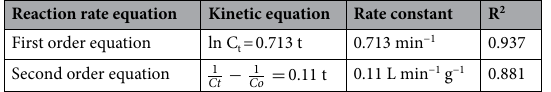
Table 2. The rate of reaction of 1 g/L initial oil concentration.